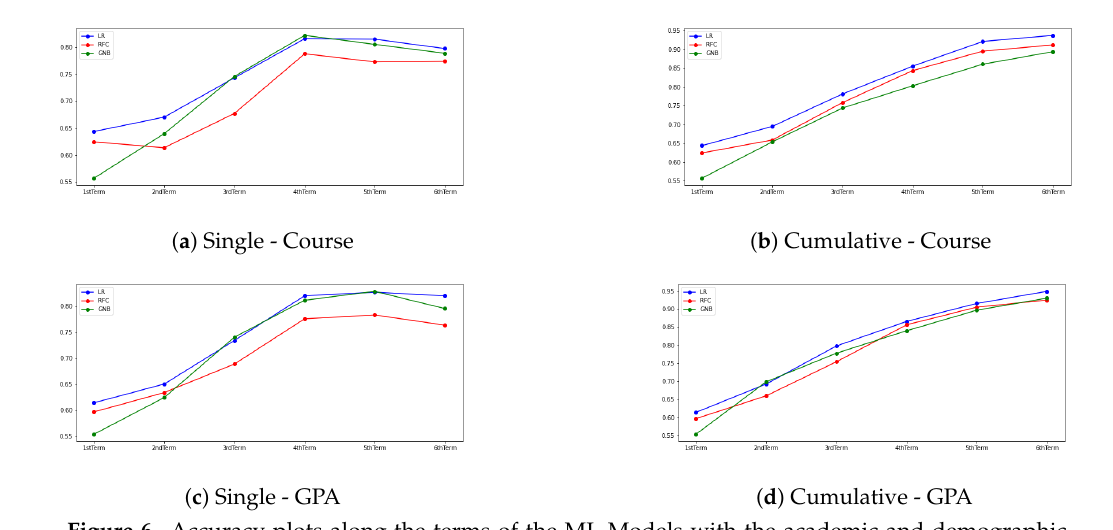
Figure 6. Accuracy plots along the terms of the ML Models with the academic and demographic features.